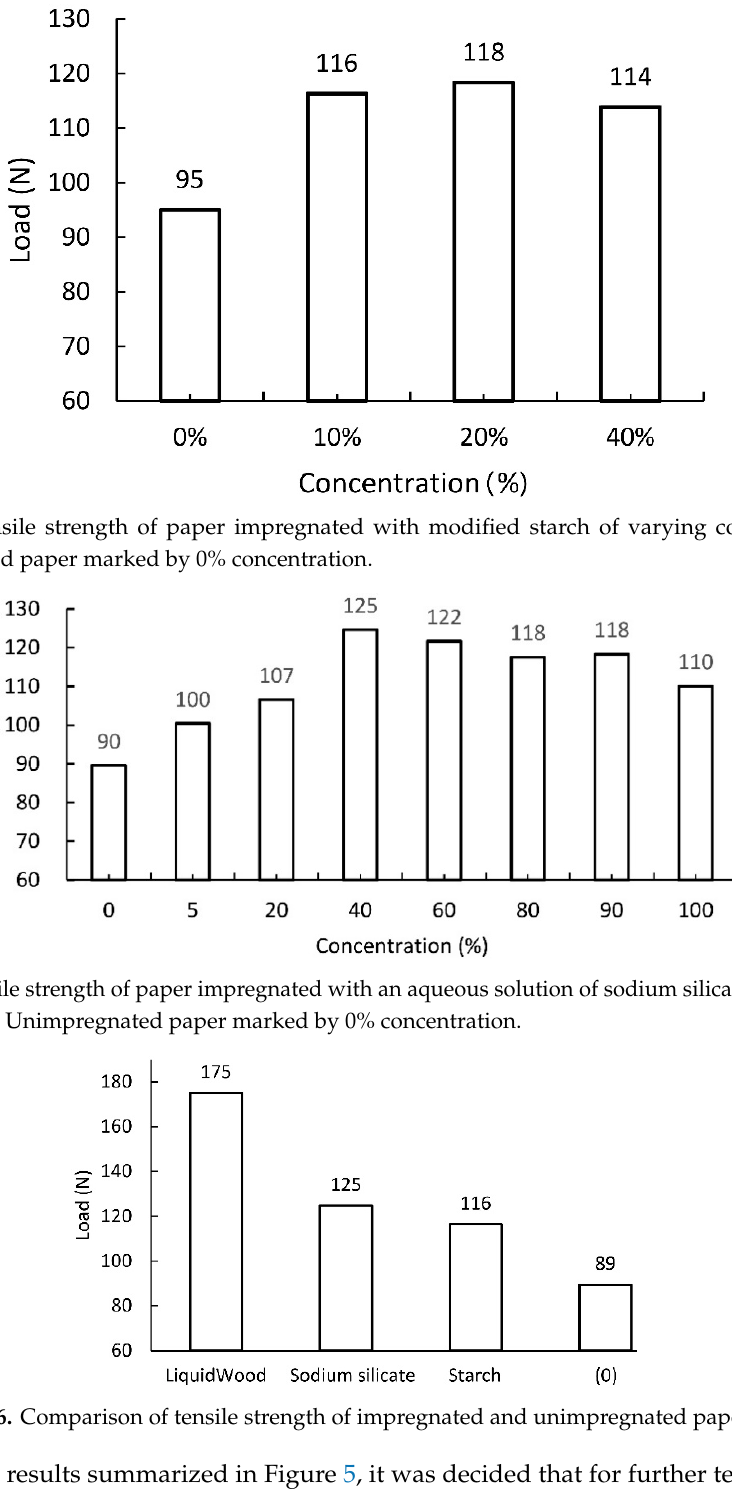
Figure 6. Comparison of tensile strength of impregnated and unimpregnated paper (0).